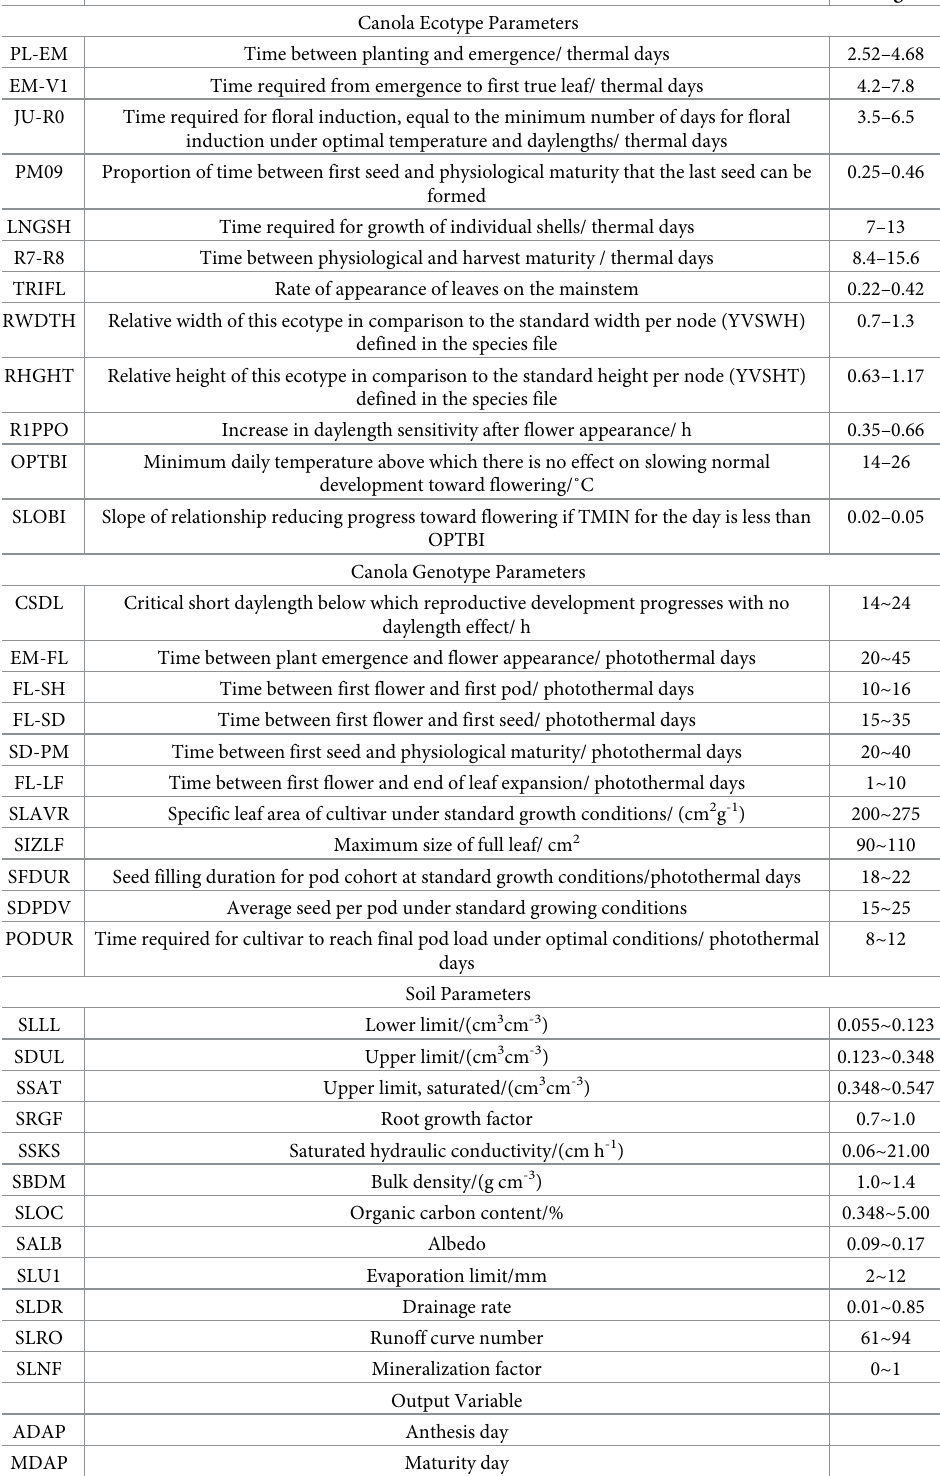
Table 3. Selected parameters and output variables in CROPGRO-Canola